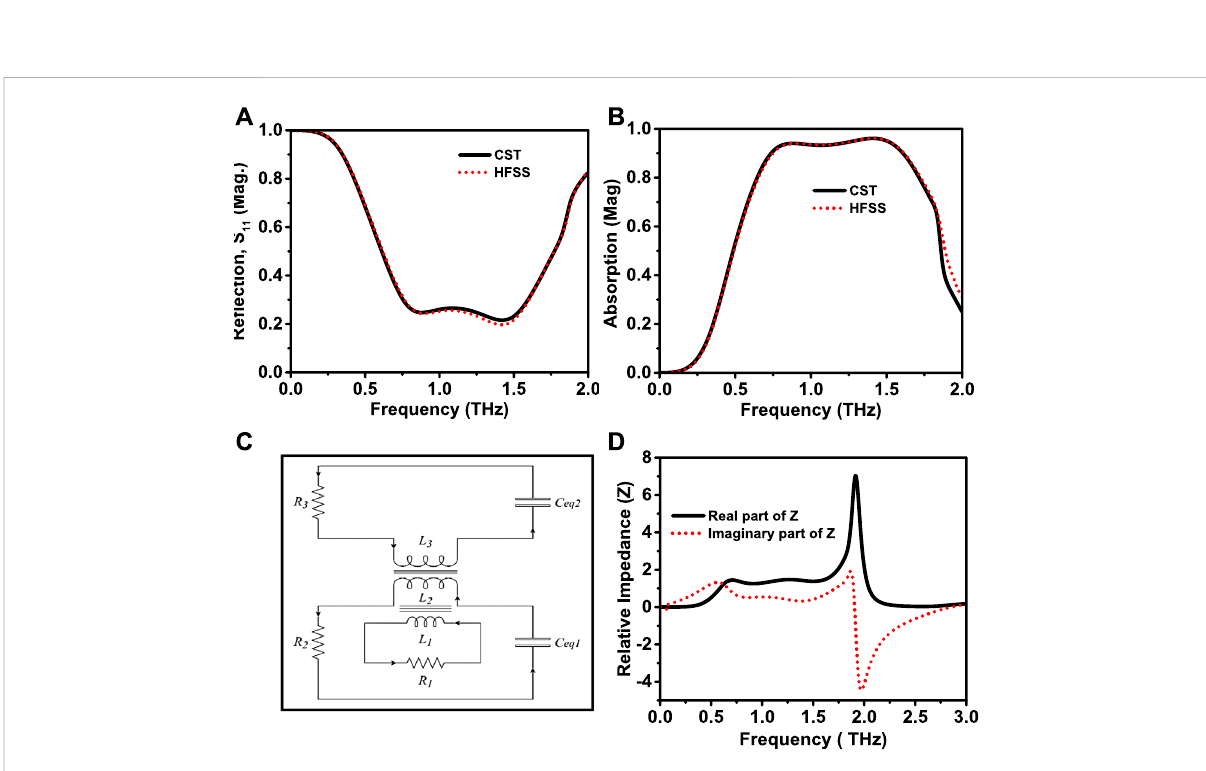
FIGURE 19 (A) ComparisonofthesimulatedCSTandHFSSsoftwareforthere fl ectionspectra (B) ,absorption coef fi cient, (C) equivalentcircuitdiagramand (D) real and imaginary part of the impedance for the proposed